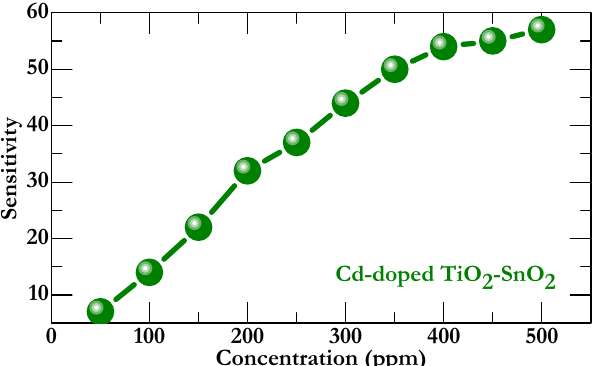
Figure 6. Variation of sensitivity as a function of formaldehyde gas concentration for the Cd-doped sensor. The operating temperature is maintained at 593